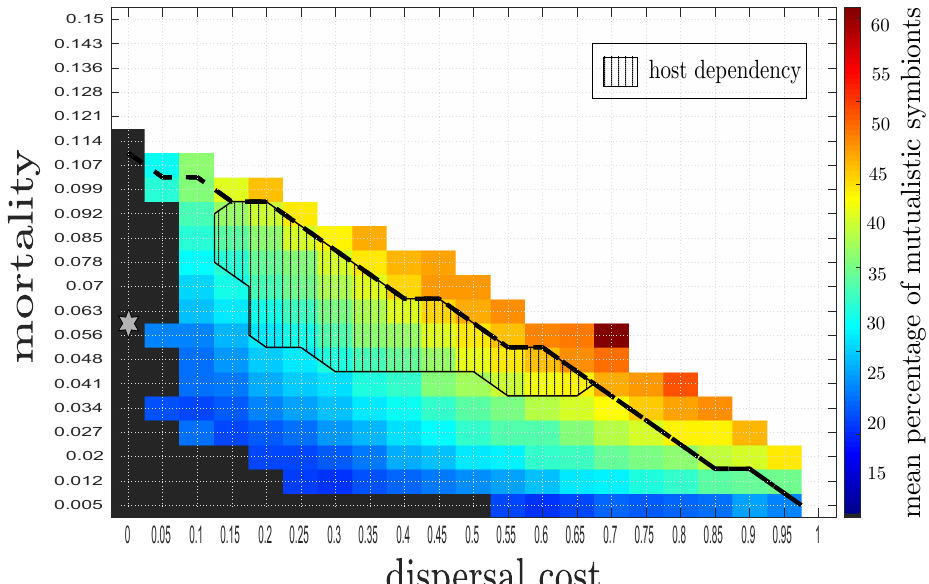
Figure 6. Percentage of mutualistic symbionts as a function of intrinsic mortality m and dispersal cost d . We run 50 simulations per parameter combination, with strong global competition γ C = 0 . 2 and w h = 1 with a 4 maximum projection time of 10 steps. The percentages are averaged over the simulations leading to tran- sition, if any occur. Above the black dotted line, the parasitic system is not viable, although the evolution of mutualism can occur above this line (evolutionary rescue). White cells correspond to the nonviability domain for the whole system, even with evolution. In the dark grey area, none of the simulations gave birth to transi- tions. The evolution of host ecological dependency occurs in the hatched area, where an average isolated host has a negative growth rate because of intraspecific competition. The grey star corresponds to the restrictive h = 0 . 1 , f s = 2 . 5 , f max = 8 , f a = 0 . 5 and conditions of Figure 2. Other parameters are c m = 0 . 3 , f min min β max = 0 . 5